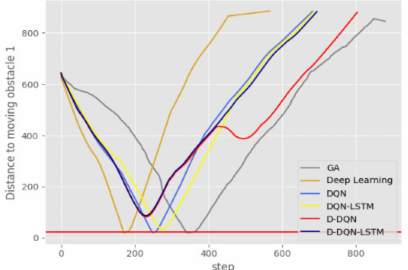
Figure 18. Change in the distance between AUV and moving obstacle 1 in a complicated environment.